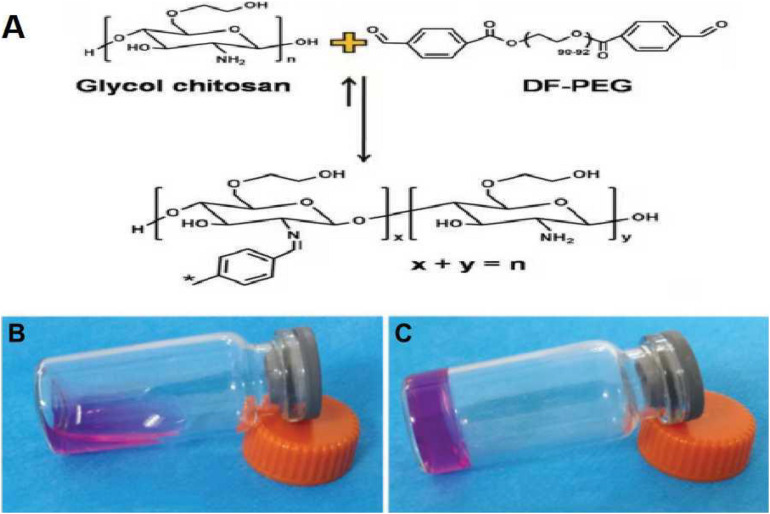
Hydrogel gelation principle and morphology before and after gelation. (A) The principle of hydrogel gelation. (B) Hydrogel morphology before gelation. (C) Hydrogel morphology after gelation.